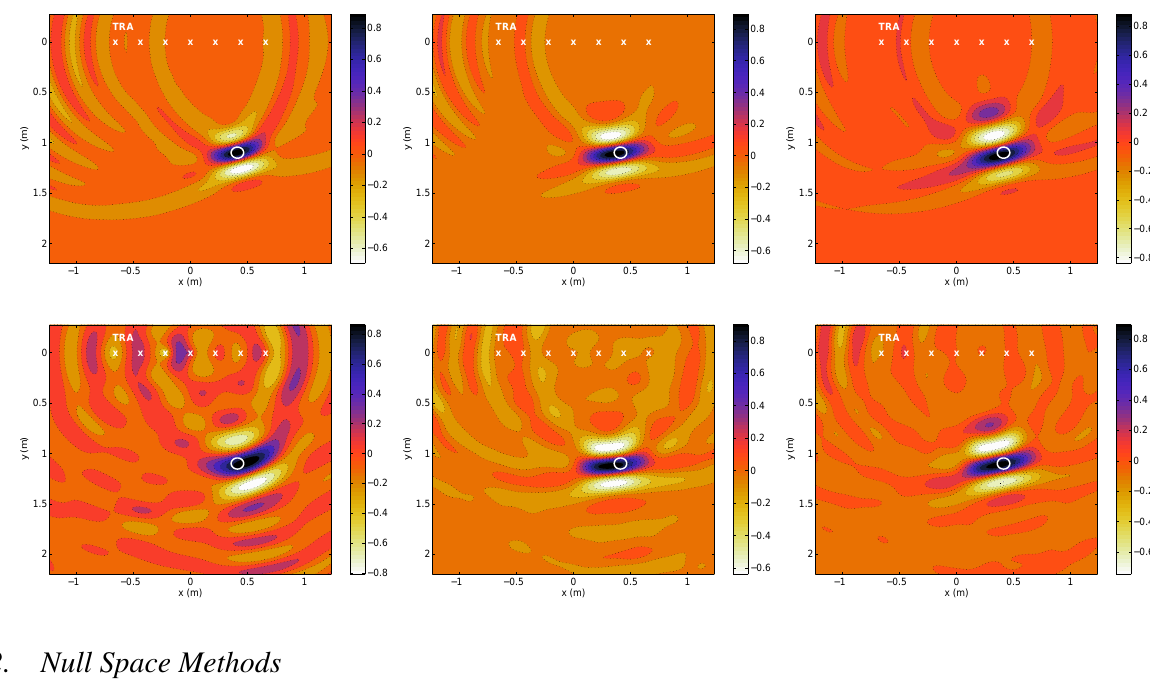
Figure 9. Images (in linear scale) obtained both in homogeneous (top row) and random (bottom row) media by TD-DORT (1st column), SF-imaging using individual (2nd column), and full SF-MDMs (3rd